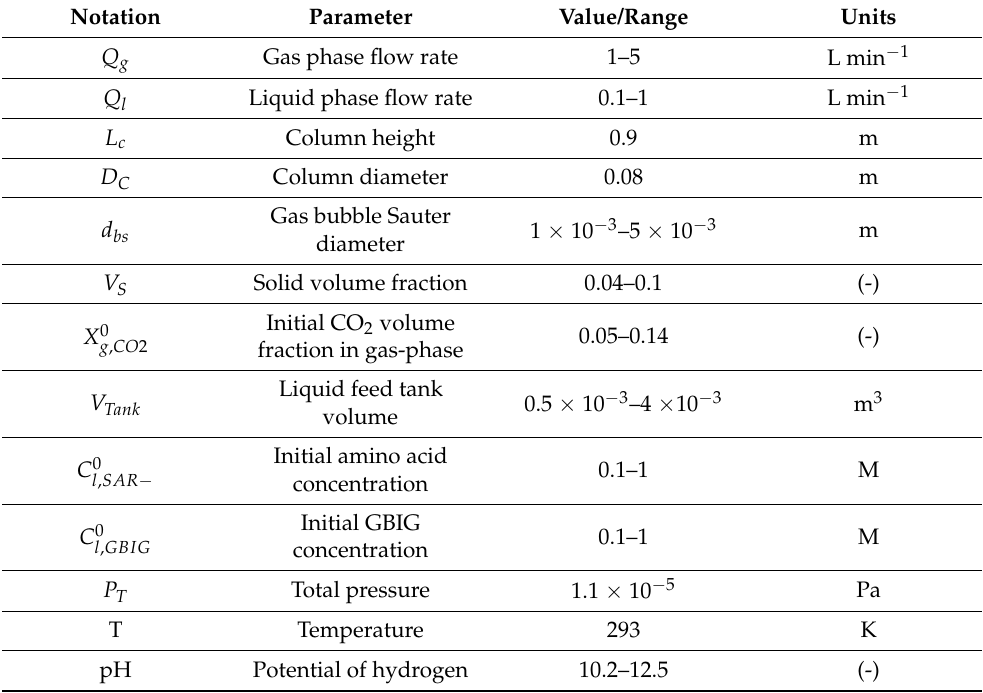
Table A3. Values used in the